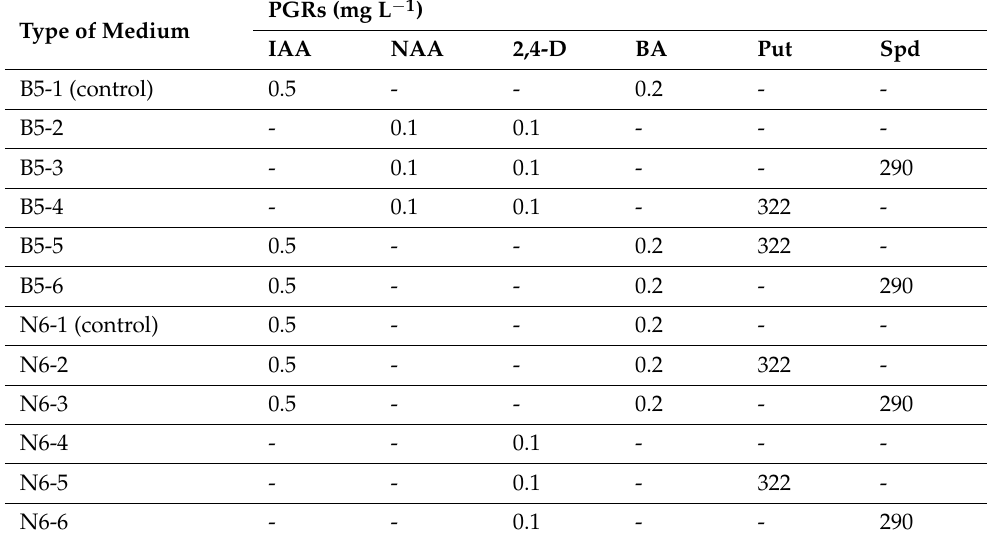
Table 1. Components of the induction media prepared based on the B5 and N6